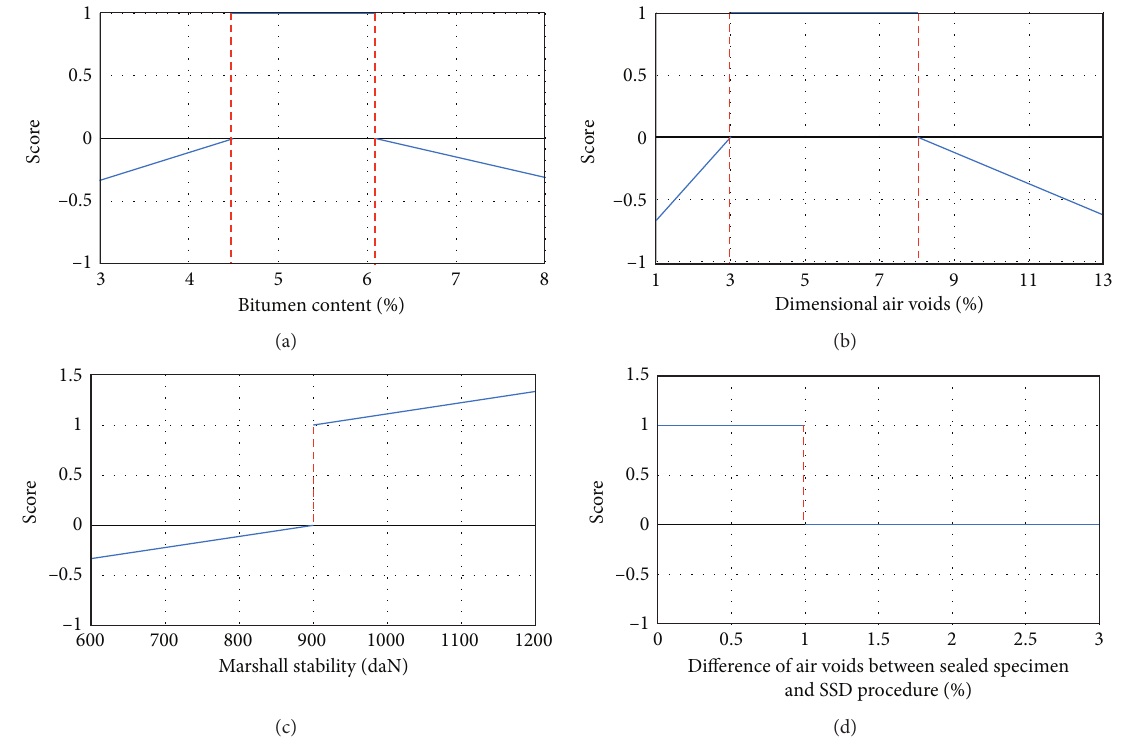
Figure 12: Graphic representation of the positive and negative score assigned to the bituminous mixtures based on the bituminous mixtures’ sample characterization.